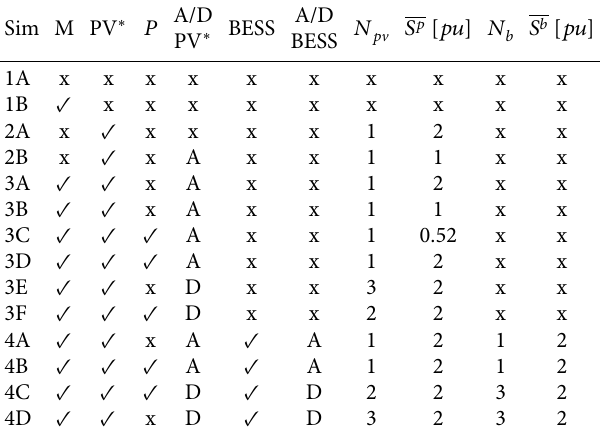
Table 2: Case simulation and constraints